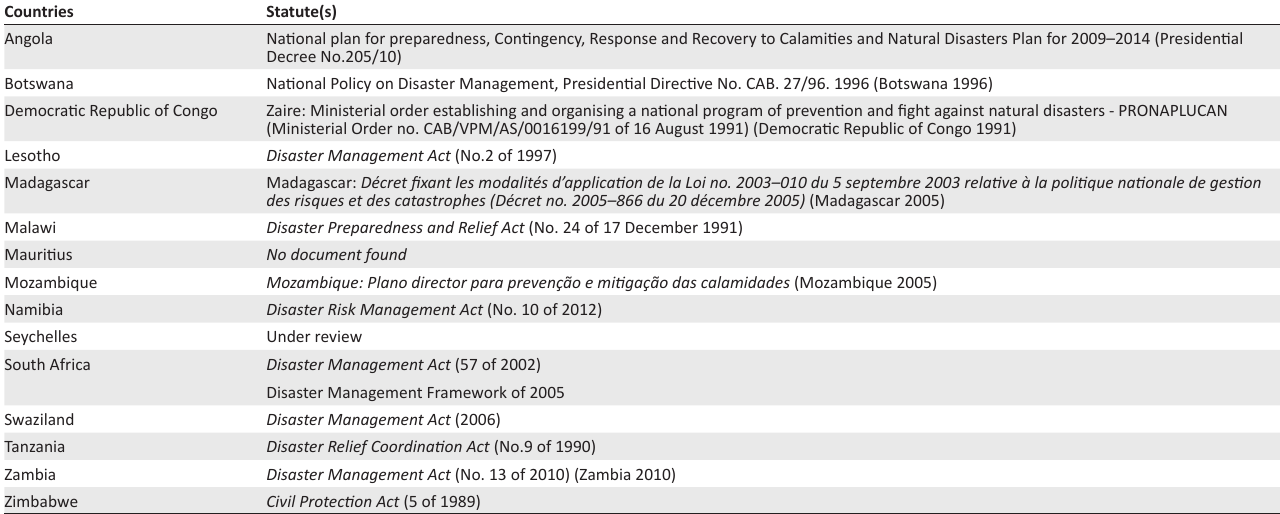
TABLE 4: List of Southern African Development Community countries and statutes used for disaster management or civil protection. Countries